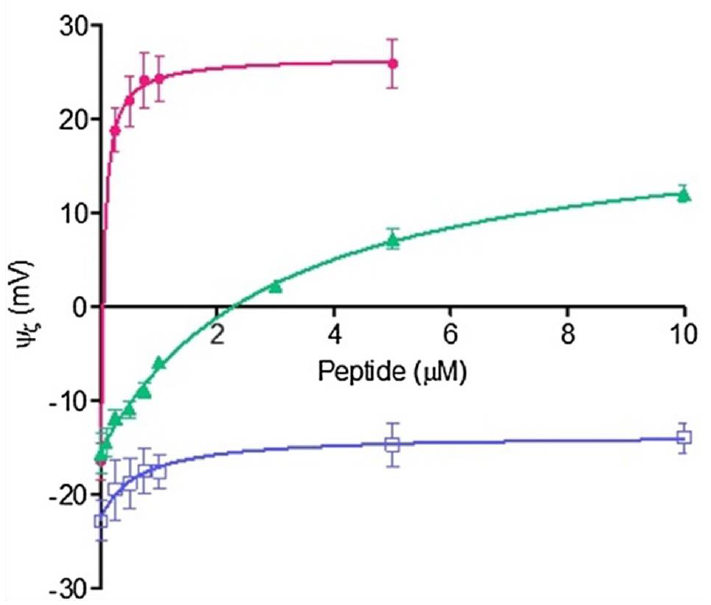
Figure 5. Effect of Melittin ( ● ), Arg 7 ( ▲ ) and Lys 5 ( □ ) on the zeta potential of DMPC liposomes. Inset: maximum values obtained at high peptide concentration. Adapted from ref. [29].